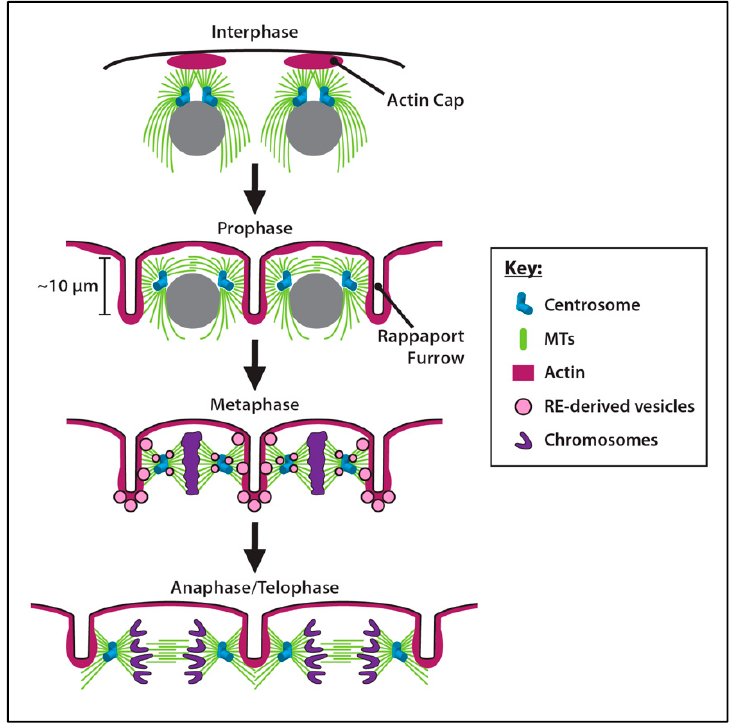
Figure 4. Centrosomes are essential to organize Rappaport furrows during embryonic cleavage cycles. The dynamics of centrosomes and furrow formation during cleavage cycles. Figure based on [174].